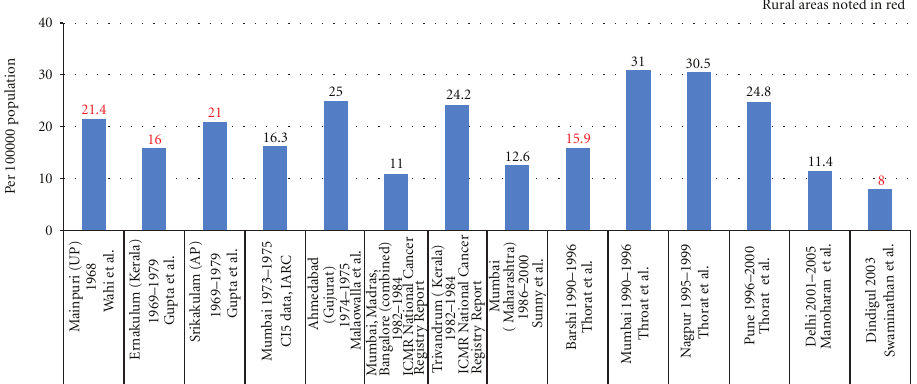
Figure 2: Age standardized incidence rates per 100,000 population for oral cancer reported in reviewed literature—by location and time period (in males only).